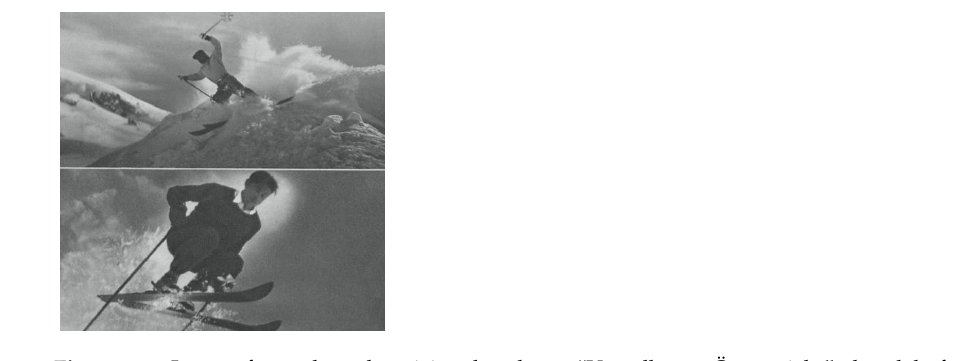
Figure 1. Image from the advertising brochure “Vorarlberg, Österreich,” dated before 1938 (Groß 2011, p. 136; original document in Vorarlberger Landesarchiv, Fremdenverkehr, Schachtel 25).